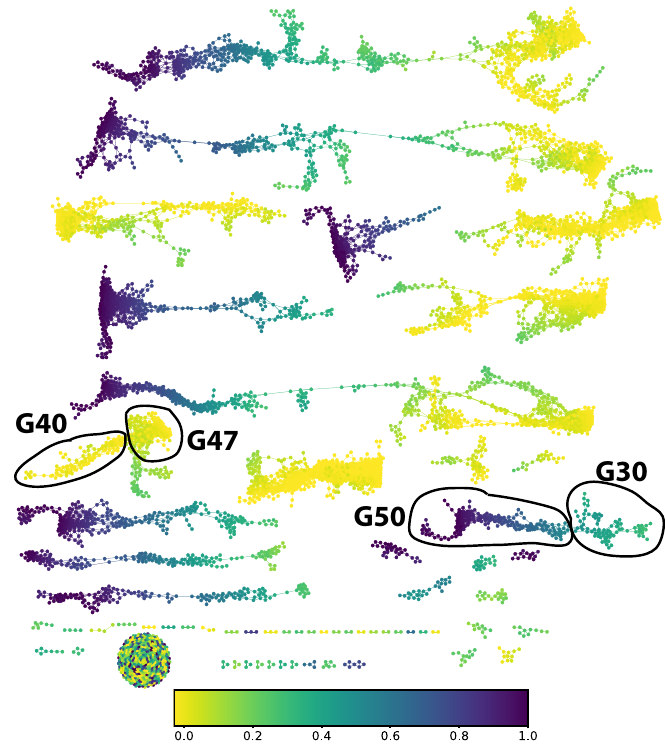
Figure 6. One of the five M APPER graphs created by the activations from the CNN model on four of the five folds, i.e., 16,000 images (5-fold-training), as explained in Section 2.8.1. The graph is colored with the probability of predicting the ground truth digit. The colorbar is for interpreting the values of the coloring. The circled nodes and edges are the groups 30, group 40, 47, and 50. The other four M APPER graphs are shown in the Supplementary Material [78].